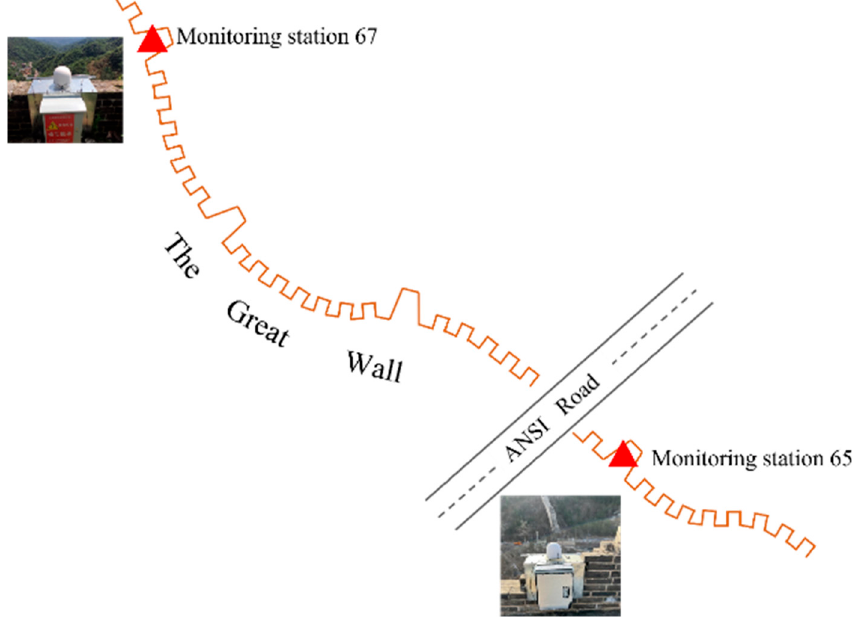
Figure 2. The layout of GNSS and 3 − axis Accelerometer.